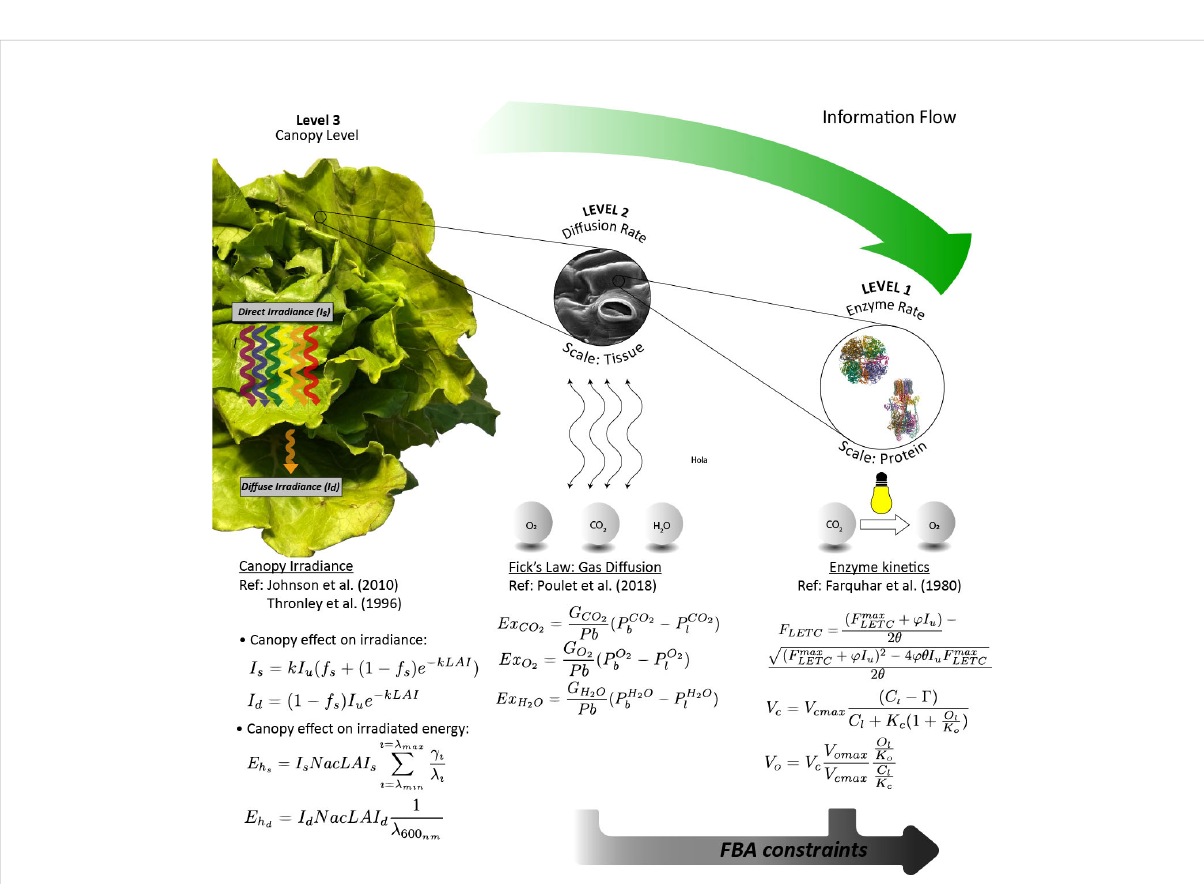
FIGURE 1 Graphical scheme of the multilevel mechanistic model approach used for L. sativa prediction